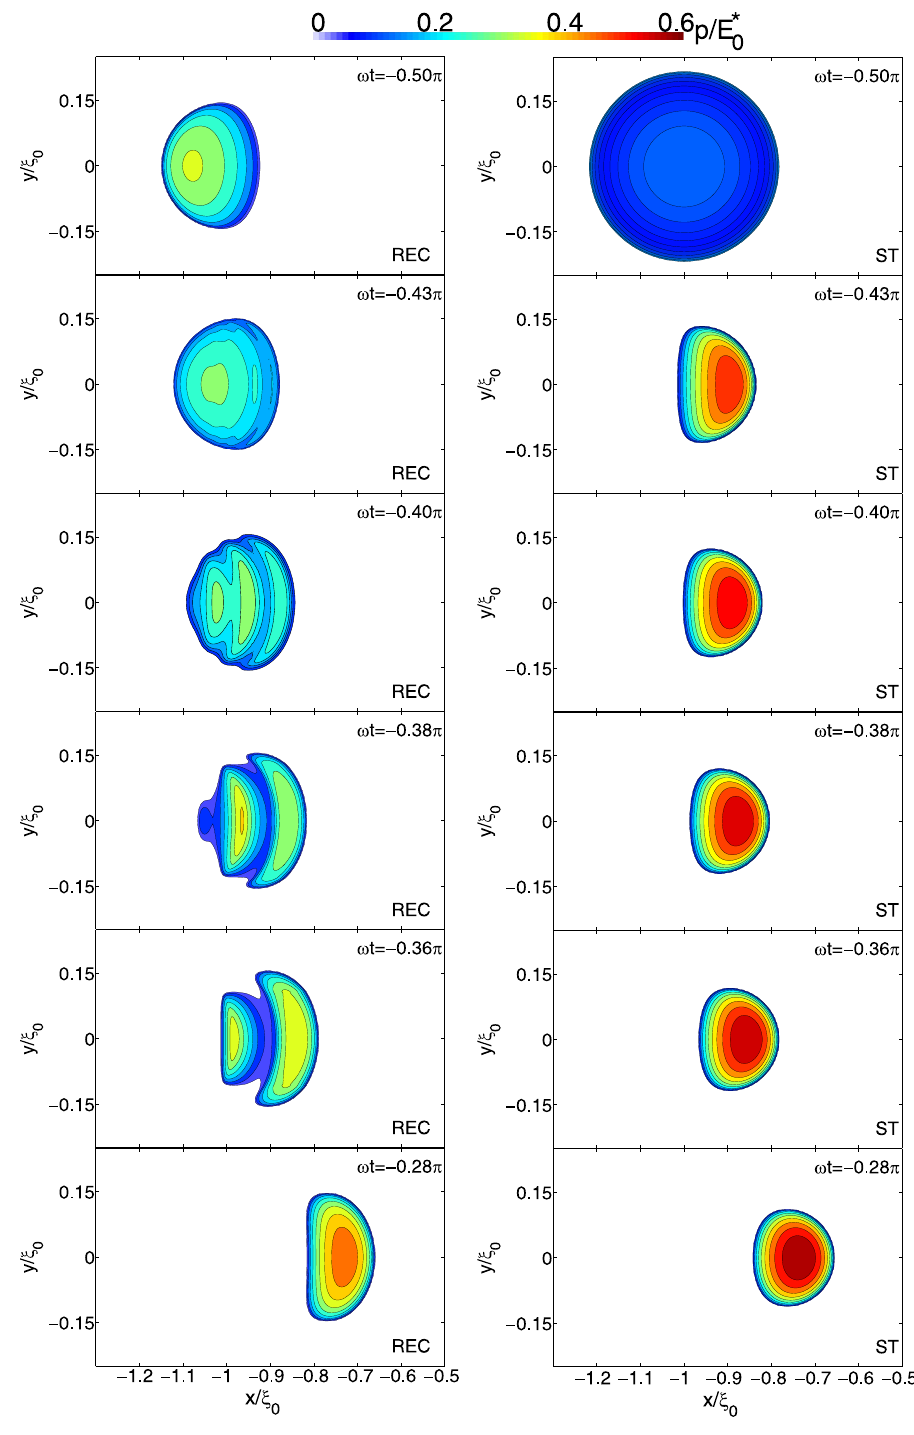
Figure 3. The contact area and the contour plots of the normalized contact pressure distributions, ⁎ p E / several values of ω t . Calculations are carried out with the viscoelastic reciprocating theory ( on the left ) and the steady-state approach ( on the right